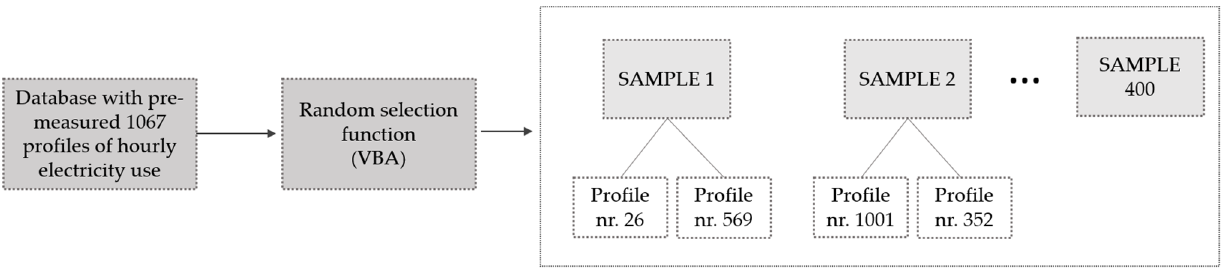
Figure 4. Example of the randomization process of two-household-combinations using the VBA- coding application in Excel.